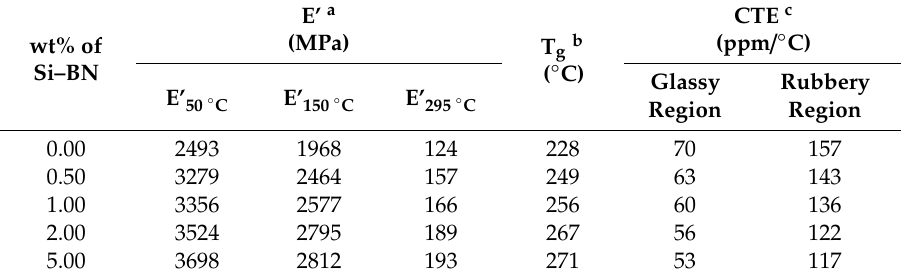
Figure 6. TMA thermographs of neat K–LCE and K–LCE / BN composites. Table 1. Thermomechanical properties of K–LCE / BN composites.